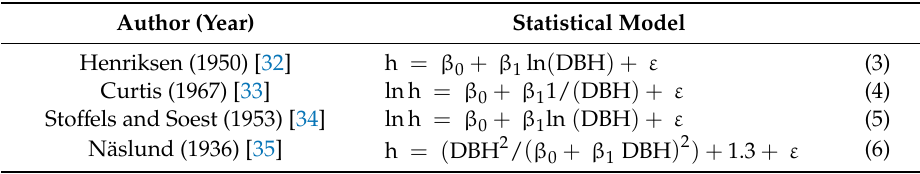
Table 4. Statistical models for estimating total height. Table 1. Descriptive statistics of height–diameter variables in the fit and validation data-sets of Ochroma pyramidale (balsa-tree) stands in Ecuador.